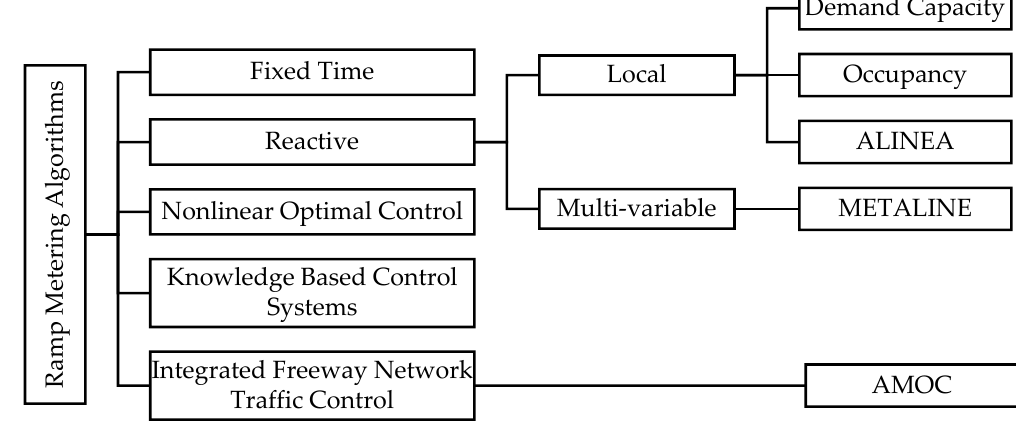
Figure 2. Ramp metering algorithms classification.